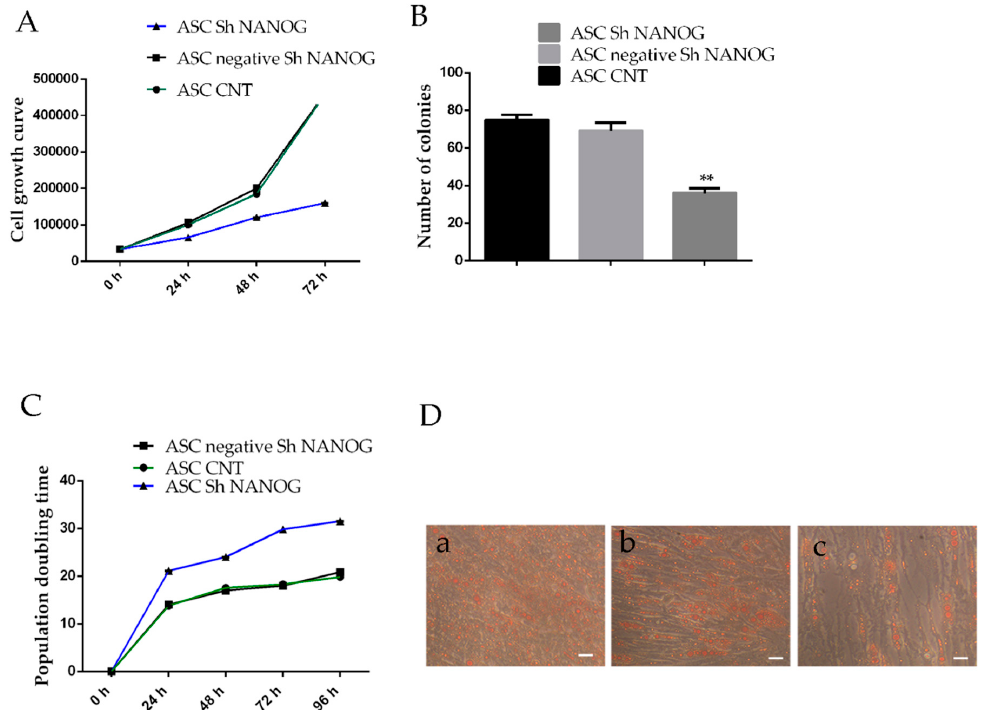
Figure 4. Time-dependent effects of downregulation of NANOG on hASCs growth, colony formation ability, population doubling time and differentiation potential. ( A ) Shows the cell growth rate over a 72-h period in freshly isolated hASCs at passage 4 (ASC CNT), hASCs lentivirally transduced with scrambled (negative NANOG ) or shRNA against NANOG using the trypan blue viability assay. ( B ) The clone numbers (more than 50 cells) of the freshly isolated hASCs at passage 4 (ASC CNT) and hASCs negative Sh NANOG were much higher than that of the hASCs sh NANOG (75 ± 5 versus 40 ± 5). ( C ) The population doubling time analysis. ( D ) Shows the differentiation potential into adipogenic lineage: (a) hASCs at passage 4 differentiated into adipocytes, (b) hASCs scrambled sh NANOG tranfected cells (hASCs negative sh NANOG ) differentiated into adipocytes and (c) hASCs lentivirally transducted with shRNA against NANOG differentiated into adipocytes. Cultures were observed under light microscopy (10×) with phase contrast with a Nikon DS-FI1 CCD camera. scale bar=10 μ m (Values are mean ± SD, ** p < 0.01). A representative photograph of the colonies formed 14 days after lentivirus transfection, stained with crystal violet, is shown in Supplementary